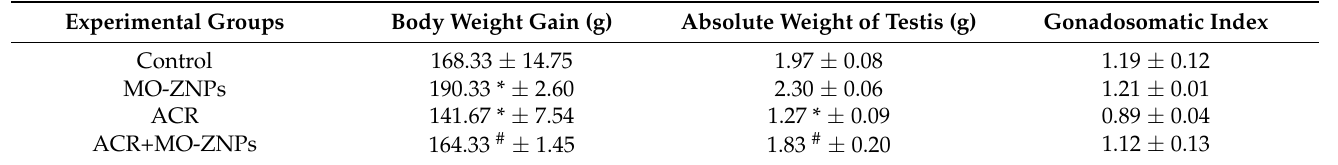
Table 2. Effect of green synthesized zinc oxide nanoparticles produced by Moringa oleifera leaf extract (MO-ZNPs) on body weight change and testes weights in acrylamide (ACR)-exposed rats. Experimental Groups Body Weight Gain (g) Absolute Weight of Testis (g) Gonadosomatic Index Control 168.33 ±